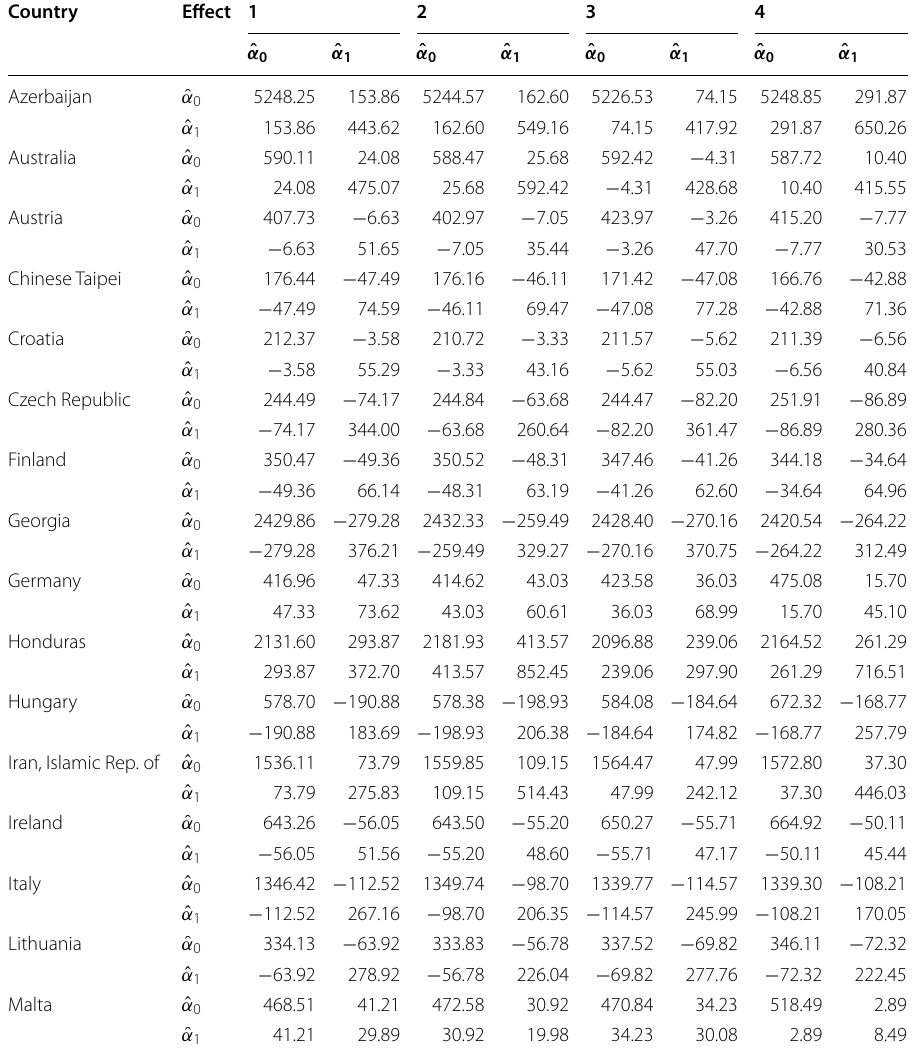
Table 10 Distribution of random effects G across scaling models and countries (Part